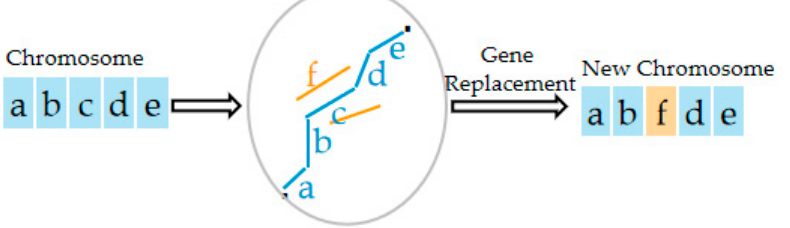
Figure 5. Schematic diagram of the gene replacement operation.